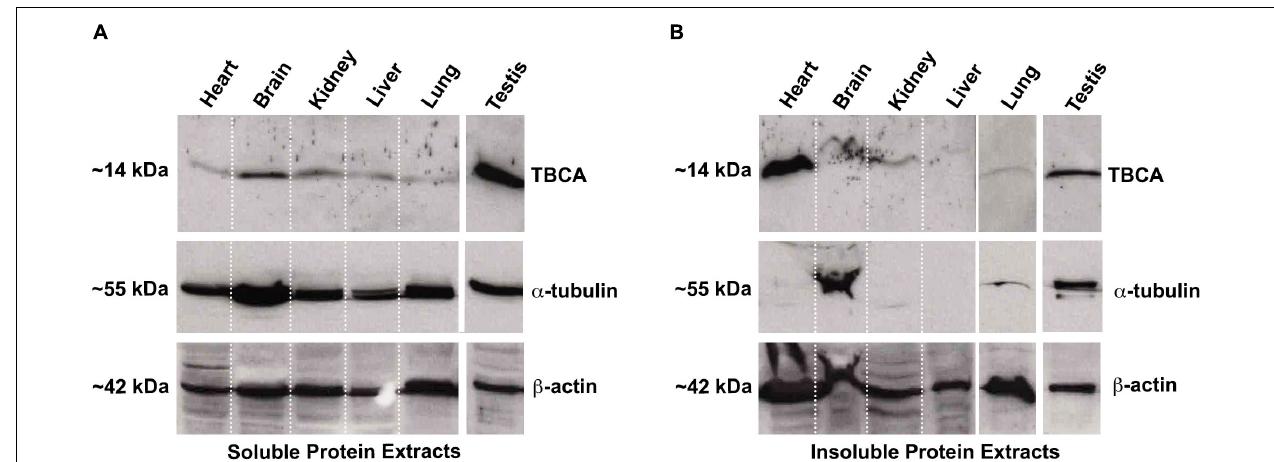
FIGURE 6 | TBCA is present in a high amount in mouse insoluble protein extracts from the heart. Soluble (A) and insoluble (B) protein extracts from mouse organs (heart, brain, kidney, liver, lung, and testis) were prepared and analyzed on 16.5% (w/v) Tricine–SDS–PAGE followed by western blot with antibodies against TBCA, α -tubulin, and β -actin. Soluble protein extracts were quantified, and equal protein amounts (100 µ g) were analyzed. Insoluble protein extracts were solubilized with 8 M urea and diluted 1:2 in loading buffer and, 20 out of 200 µ l were analyzed. (A) The analysis showed that TBCA was more abundant in testis and brain. α -tubulin and β -actin are detected in all organs. (B) The insoluble protein extracts show that TBCA is more abundant in the heart and testis. α -tubulin is mainly detected in testis and brain, and β -actin is detected in all organs. The approximate molecular mass of the proteins is indicated on the left side of the panels.